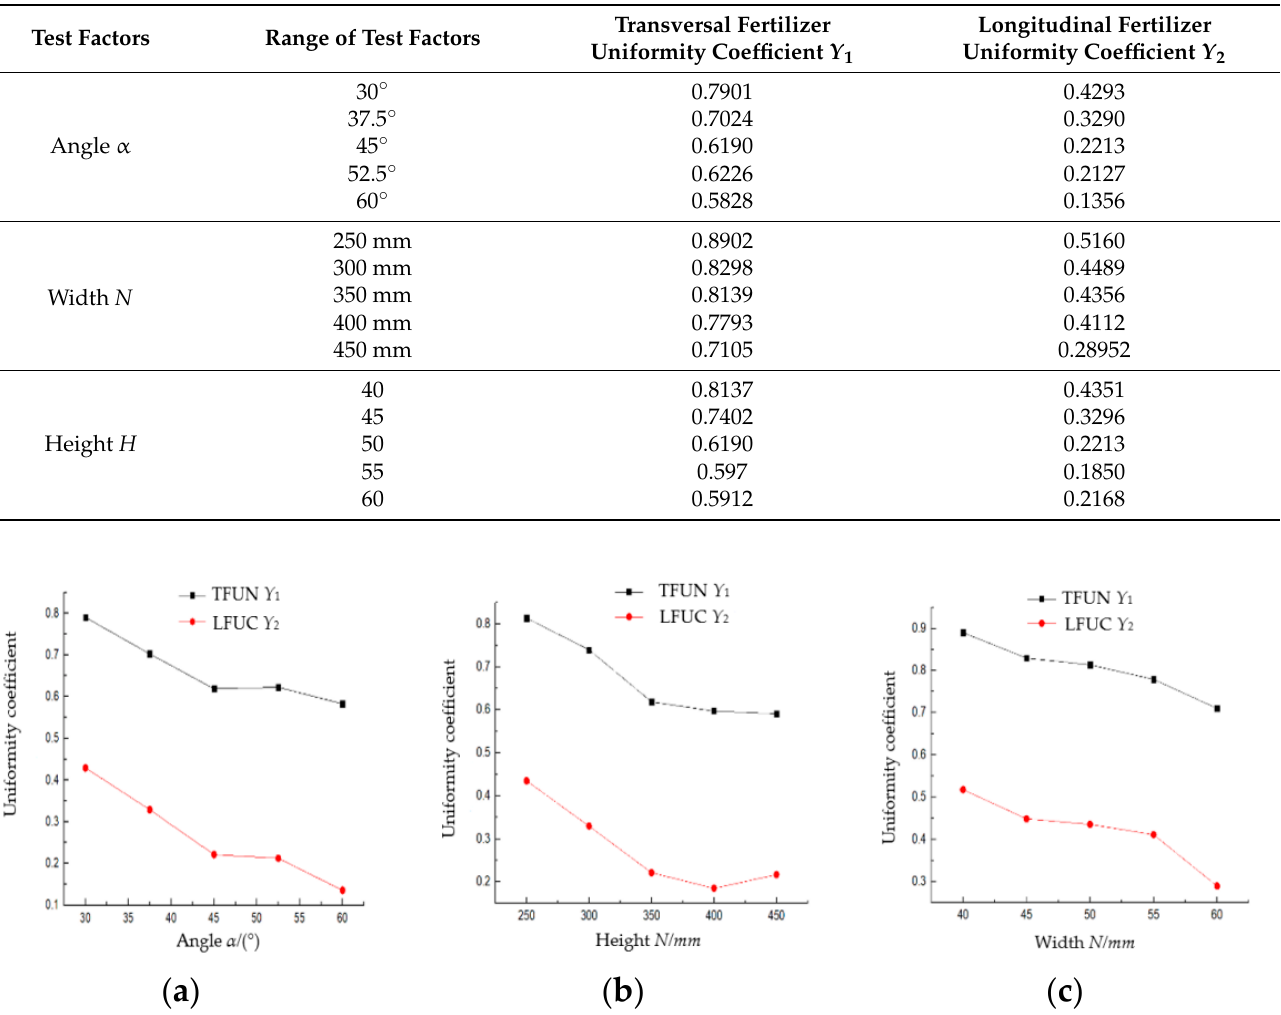
Figure 9. The influence curve of the single factor test. ( a ) Effect of angle on the transversal fertilizer uniformity coefficient and longitudinal fertilizer uniformity coefficient, ( b ) effect of width on the transversal fertilizer uniformity coefficient and longitudinal fertilizer uniformity coefficient, ( c ) effect of height on the transversal fertilizer uniformity coefficient and longitudinal fertilizer uniformity